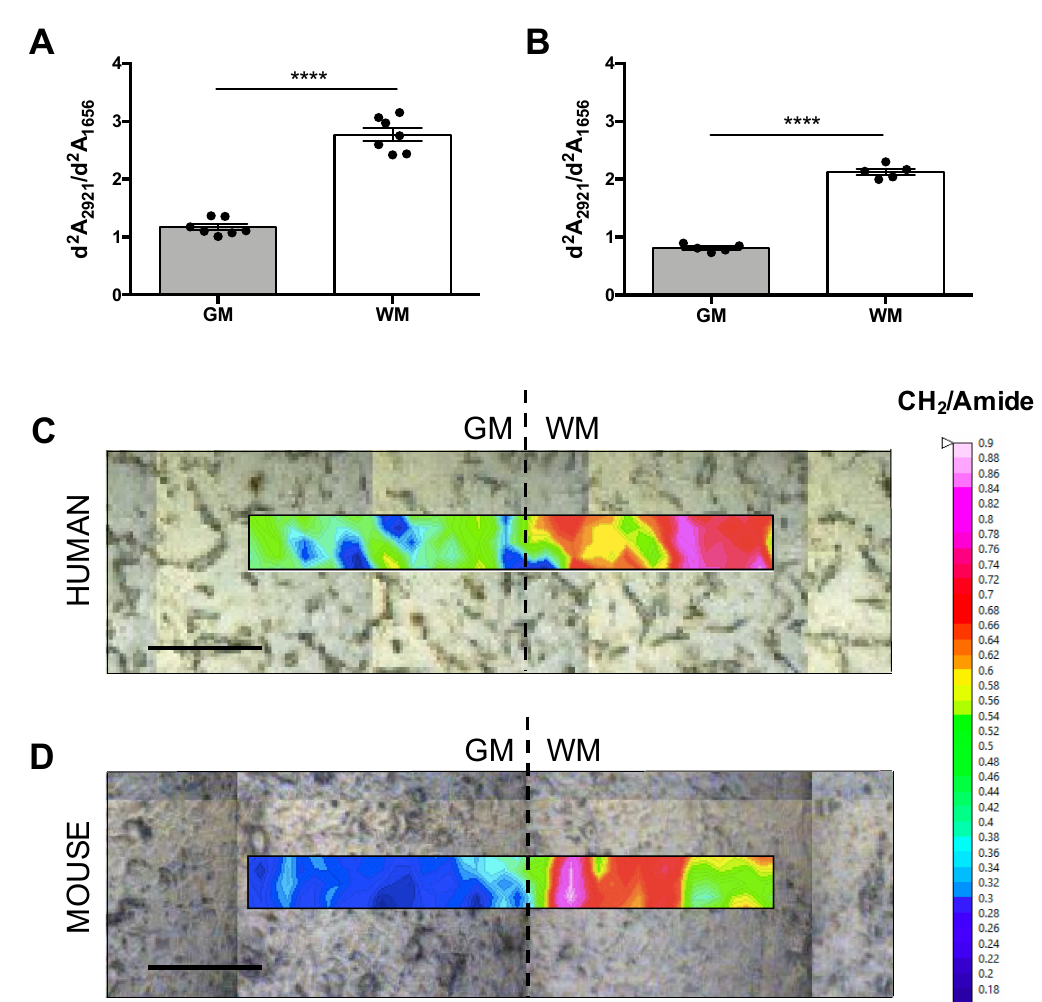
Figure 2. Lipid/Protein composition by μ FTIR in grey matter (GM) and white matter (WM). Quantification of CH 2 /Amide I absorbance after second derivative (d 2 A 2921 /d 2 A 1656 ) in humans ( A ) and mice ( B ) confirms higher lipid amount in WM with respect to GM. Each dot in the graphs correspond to the mean of approximately 100 infrared measurements from a subject. Representative in situ heat maps from human ( C ) and murine ( D ) cerebral tissue showing CH 2 /Amide I ratio. Dashed lines in the tissue images represent the limit between GM and WM. **** p -value < 0.0001. Scale bar = 50 μ m.